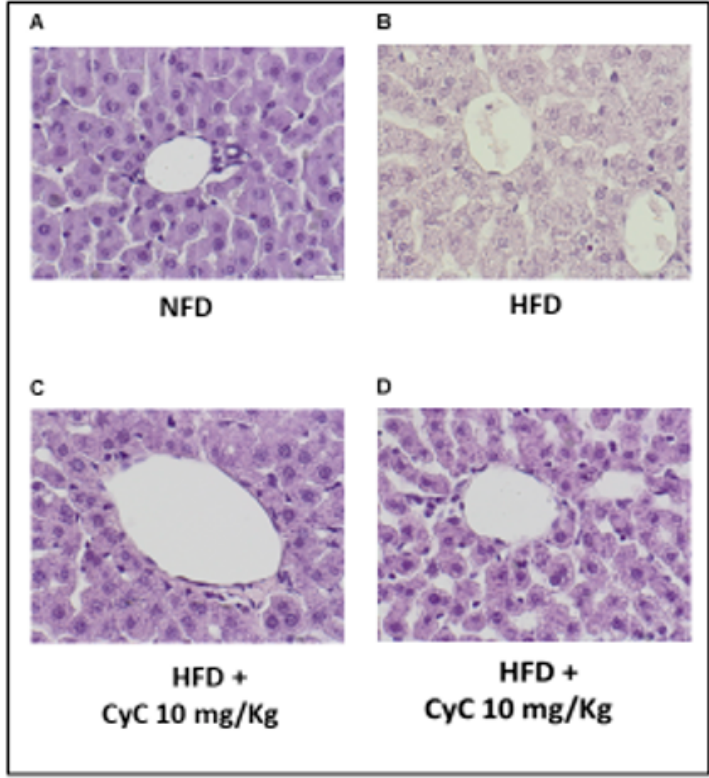
Figure 3. The effect of CyC (10 and 20 mg/kg given daily and orally over a period of four weeks) on histopathological features of liver steatosis in NFD and HFD. Histopathological sections have been stained with hematoxylin-eosin.